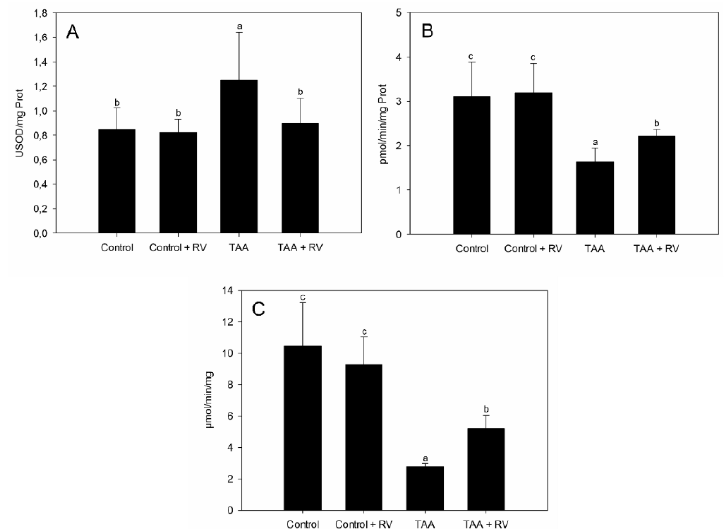
Figure 3. Effects of resveratrol and ε -viniferin on the activity of catalase, glutathione peroxidase, and glutathione S-transferase in the liver of rats with experimental severe acute liver failure: ( A ) SOD, ( B ) CAT, and ( C ) GST. Values are expressed as the mean ± standard deviation. Lowercase letters indicate significant differences between treatments ( p < 0.05), n = 7. RV: resveratrol + ε -viniferin; TAA: thioacetamide.